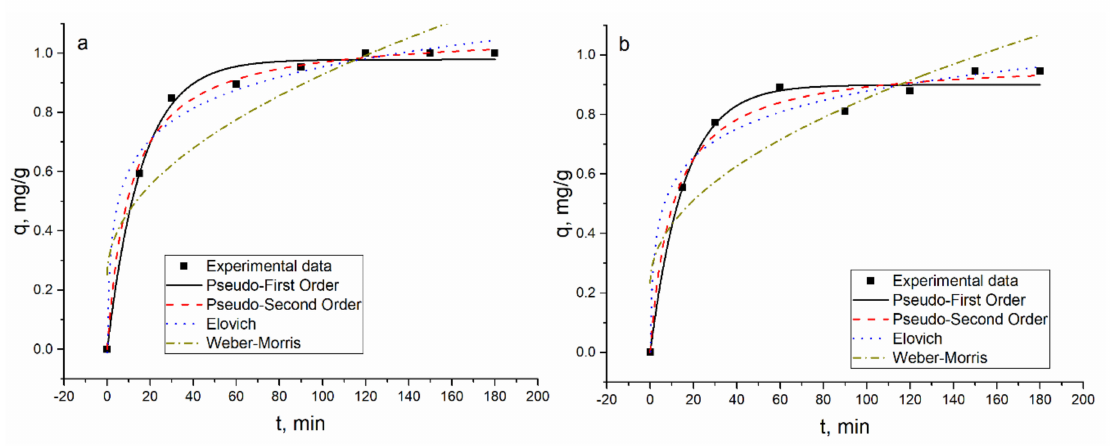
Figure 5. Ni(II) adsorption on hybrid adsorbent in the ( a ) Ni(II) and ( b ) Ni(II)-Cr(VI)-Fe(III)